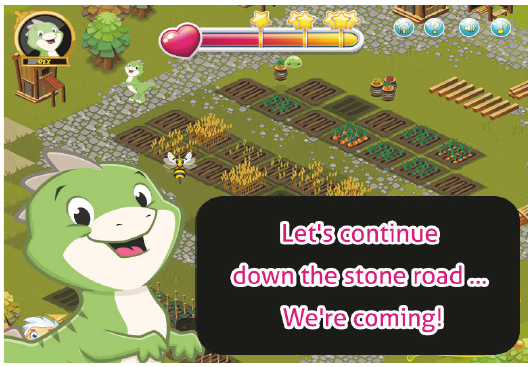
Figure 10: Interface of the environment 1 . Figure 11: Messages of